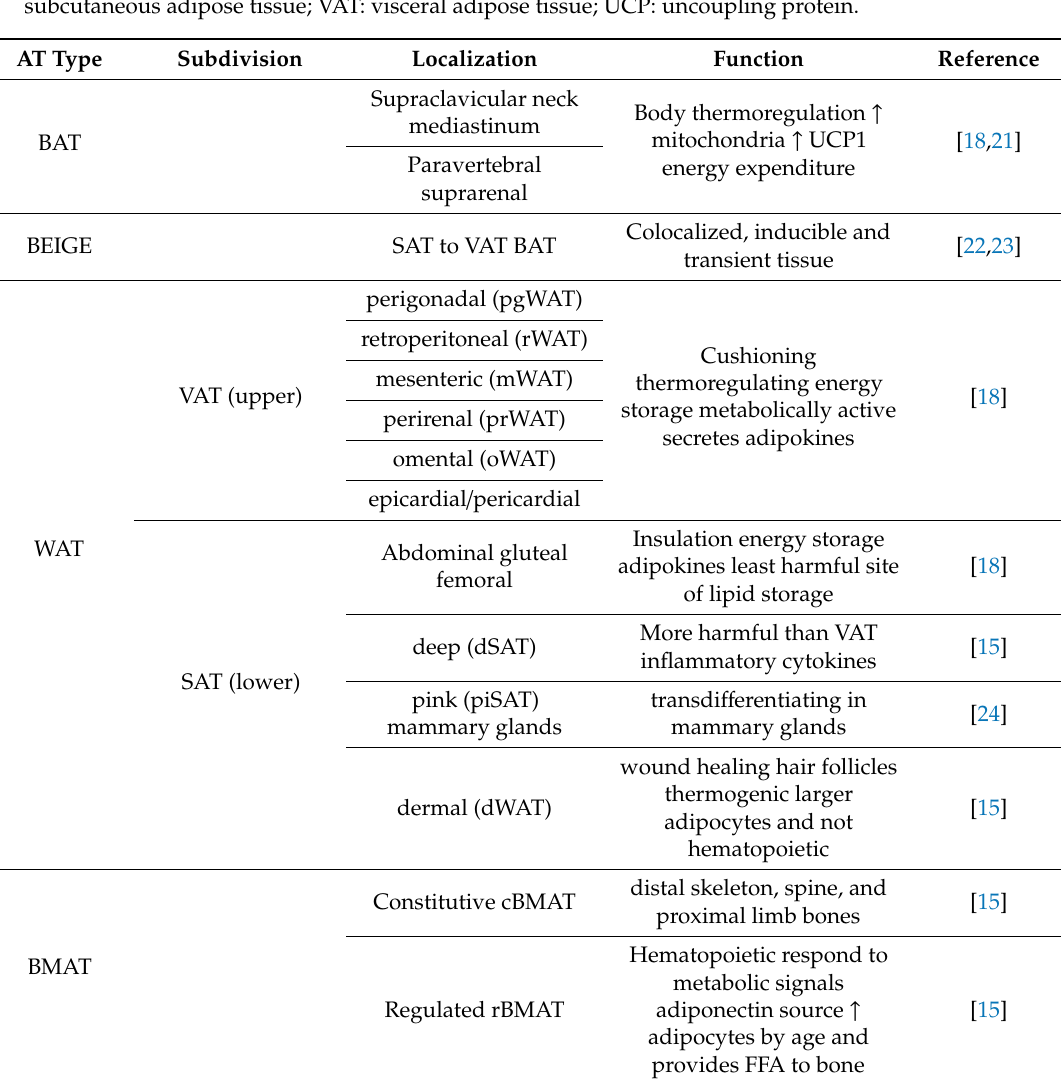
Table 1. Human adipose tissue classification, distribution, and function. In this table, the function of human adipose tissue, and how it is classified and distributed, is described. As can be seen, it is very diverse, can be located in all areas of the body and also has a specific function, depending on its location. AT is a vital tissue and is present in almost all parts of the organism. WAT: white adipose tissue; BAT: brown adipose tissue; BMAT: bone marrow adipose tissue; FFA: free fatty acids; SAT: subcutaneous adipose tissue; VAT: visceral adipose tissue; UCP: uncoupling